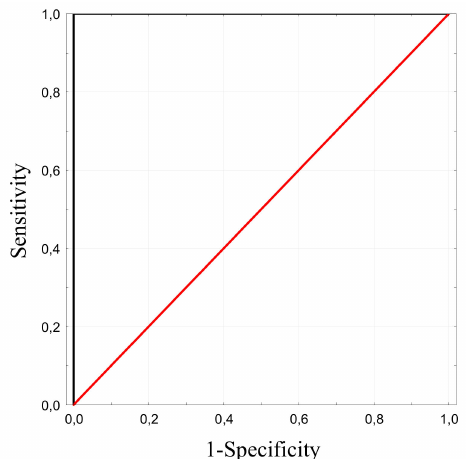
Figure 4. The receiver operating characteristic (ROC) curve for the chromosomal ratio as a predictor for trisomy 13, 18 and 21 (identical for each trisomy). The area under the ROC curve (AUROC) is given with its 95% confidence interval. AUROC: 1 (95%IC: 1.0;